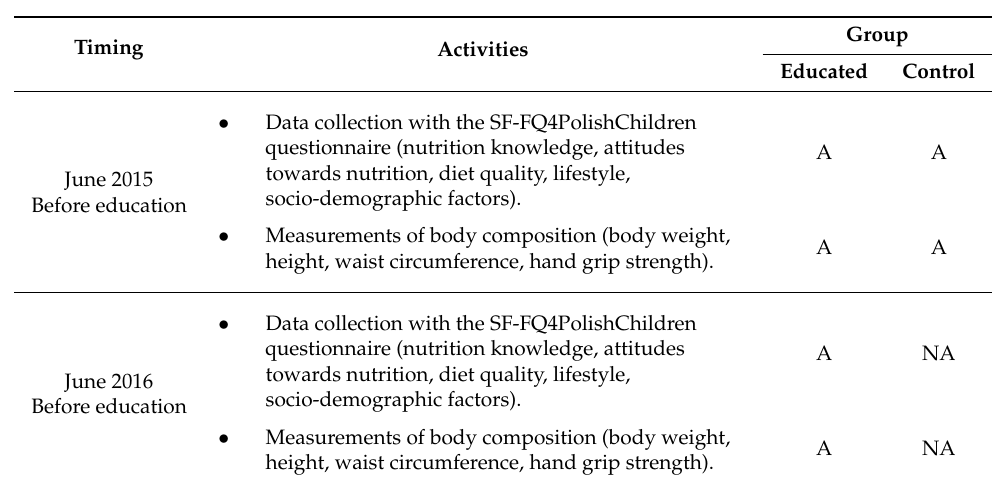
Figure 2. Flow chart of sample collection and study design. Table 3. The overall content of the cross-sectional